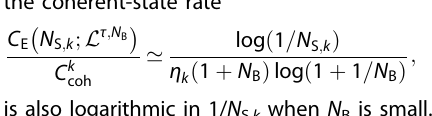
= ∞ (solid) and R = 1 (dot-dashed). For TMSV, the two 1 / R 2